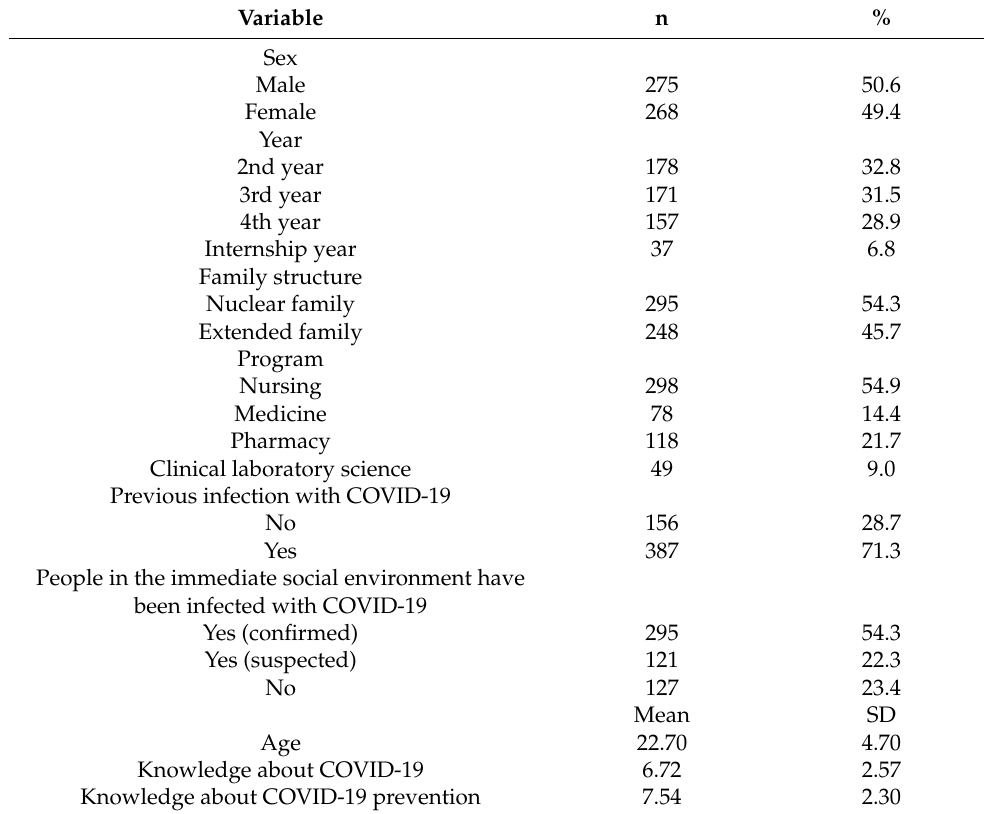
Table 1. Demographic characteristics of the participants (n = 543).